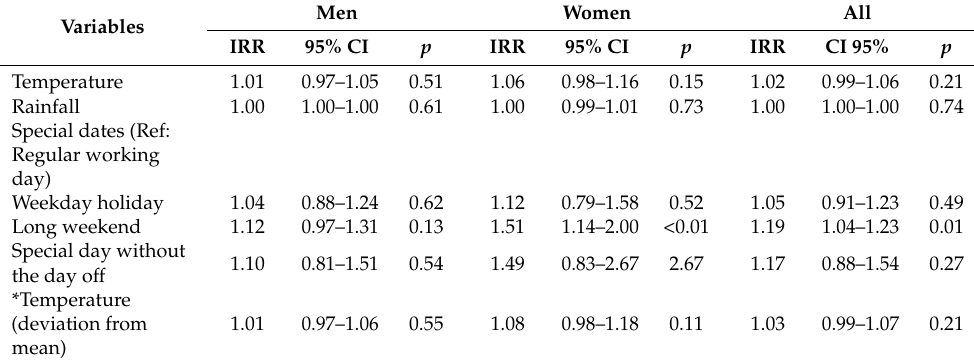
Table 2. Conditional Poisson models for daily suicides among men and women in the five main Colombian cities, 2005–2015.